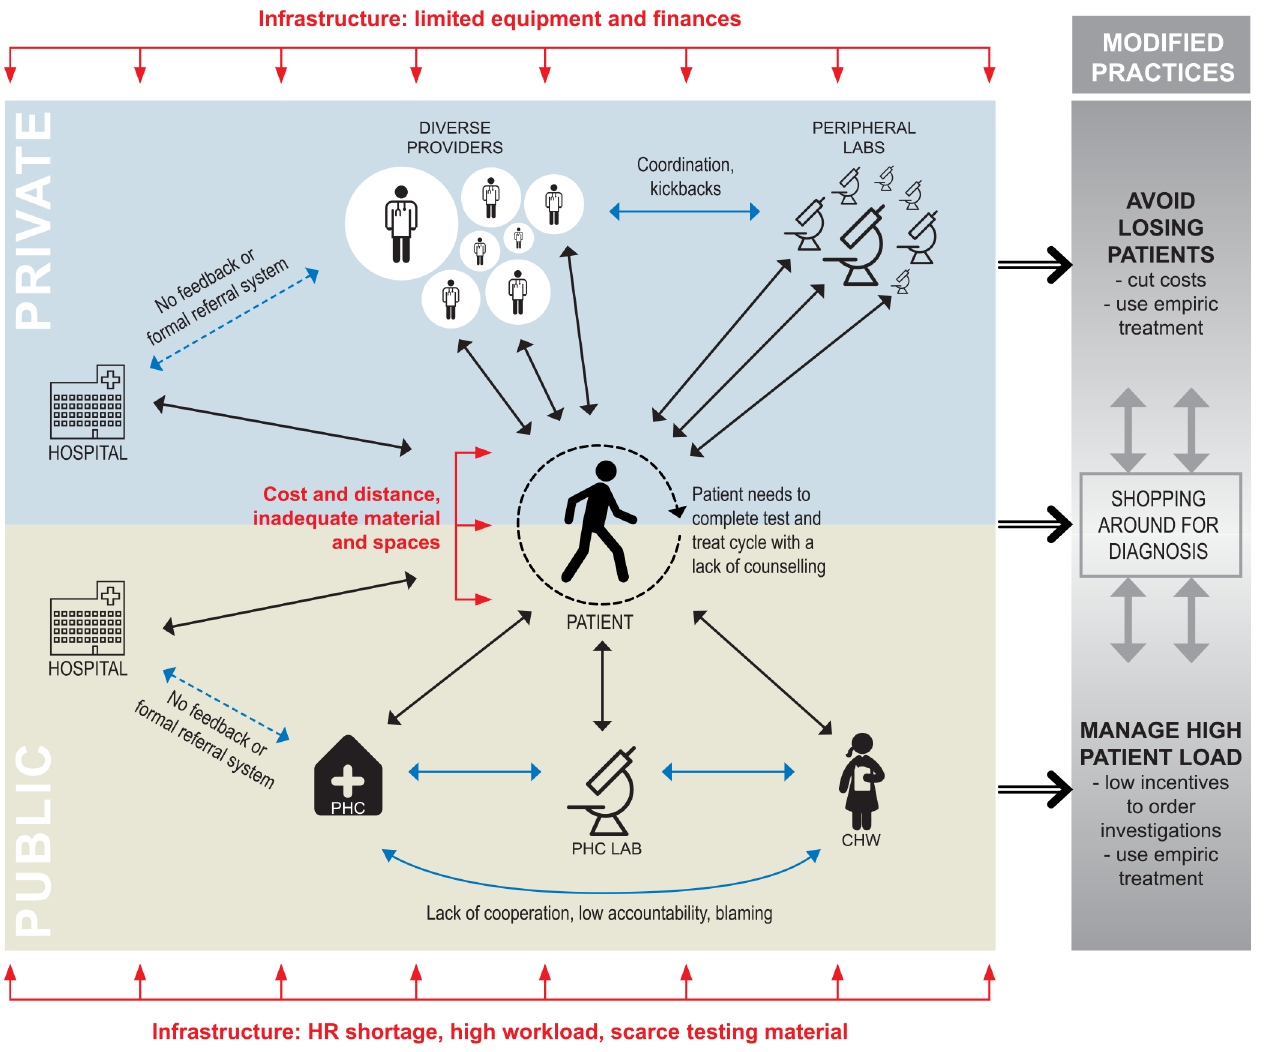
Fig 1. Barriers to POC testing: Relationships, infrastructure and modified practices. PHC- Public Health Centre. CHW – Community Health